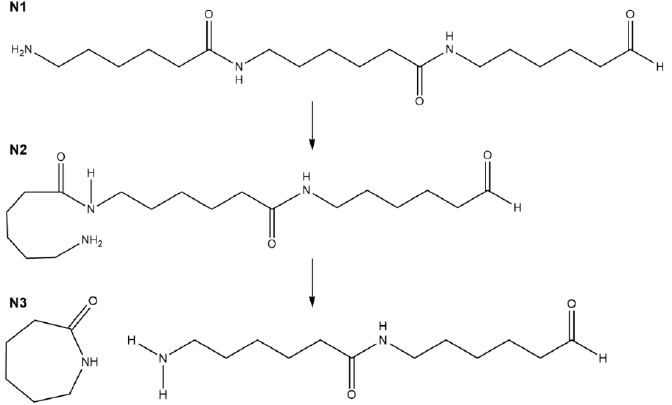
Figure 2. Mechanism of the thermal degradation of nylon 6: substrate (N1), intermediate structure (N2) and the final product (N3). (N2) and the final product